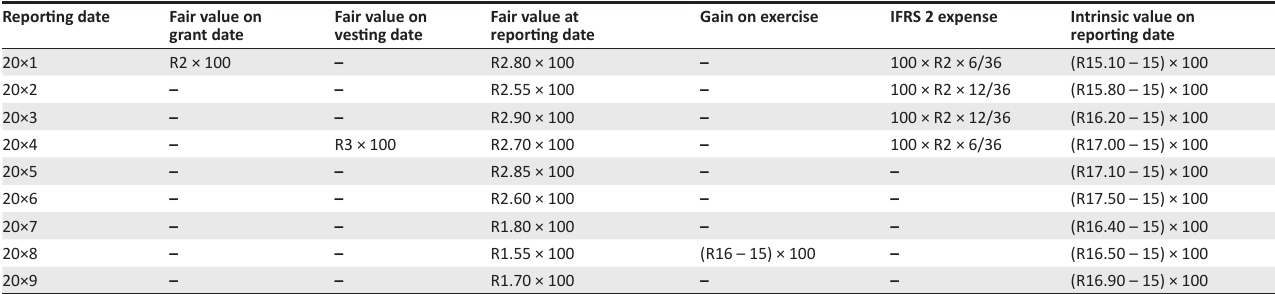
TABLE 1-A1: Calculations of values disclosed in Table